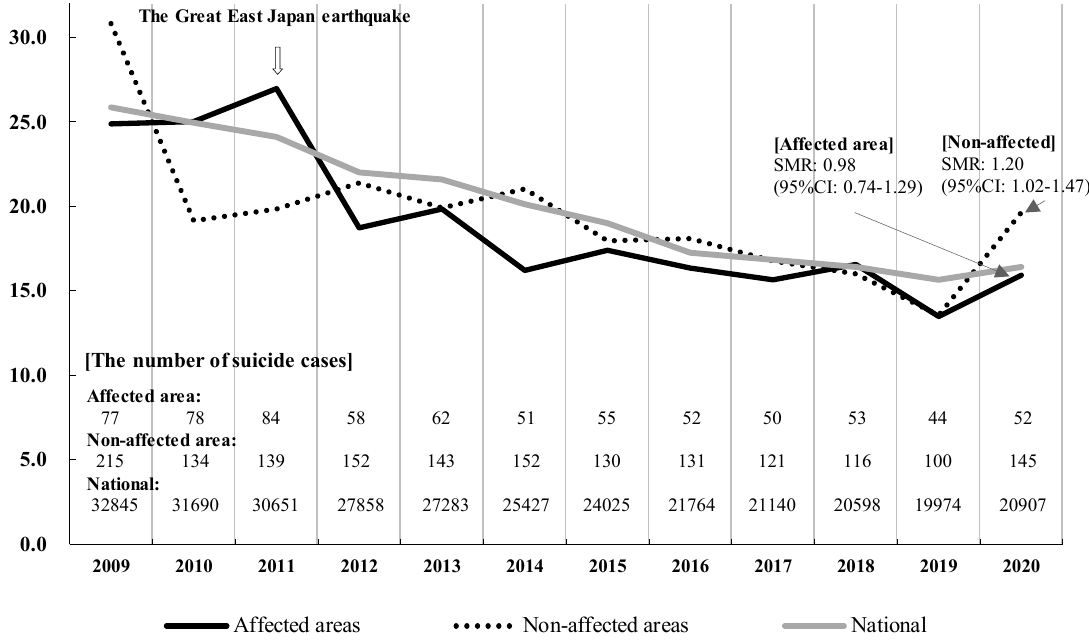
Figure 4. Suicide rate trends in severely affected areas in Sendai City, as compared with the national average. Severely affected area: Miyagino and Wakabayashi Ward in Sendai City were damaged by a tsunami disaster following the GEJE, and there was concentrated support for evacuees through disaster-related mental health interventions. Non-affected areas: Aoba, Taihaku, and Izumi Ward in Sendai City were located in the in-land area. SMR: Standardized Mortality Ratio, comparison between the severely affected area and non-affected area in 2020, and the national average in 2020.